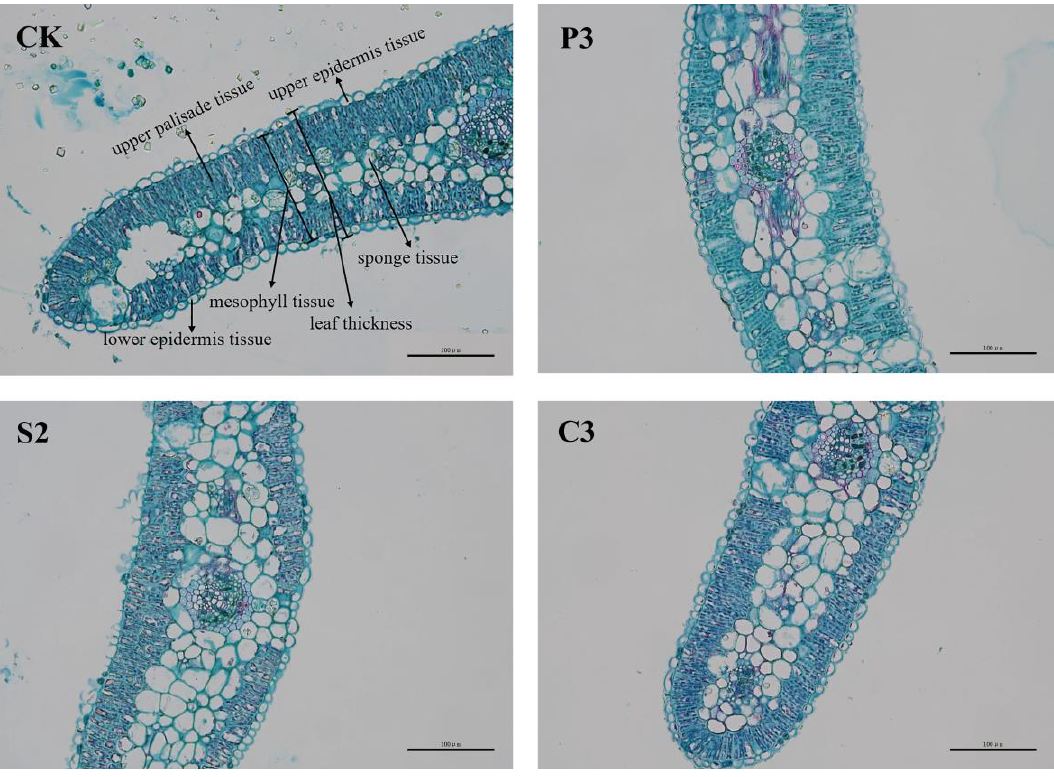
Figure 4. Anatomical structure of M. alternifolia leaves under different PGRs (× 20).